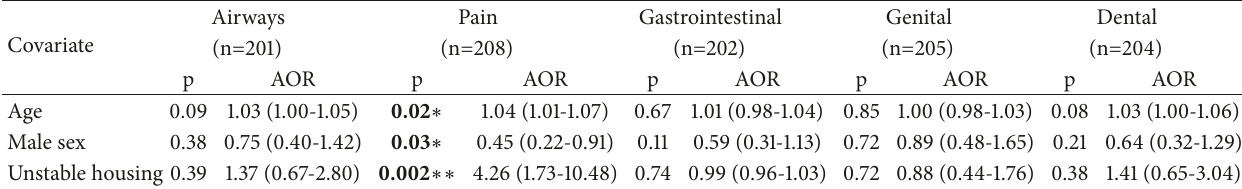
Table 4: Correlates of physical symptoms. Multivariable logistic regression. Adjusted odds ratio (AOR [95%